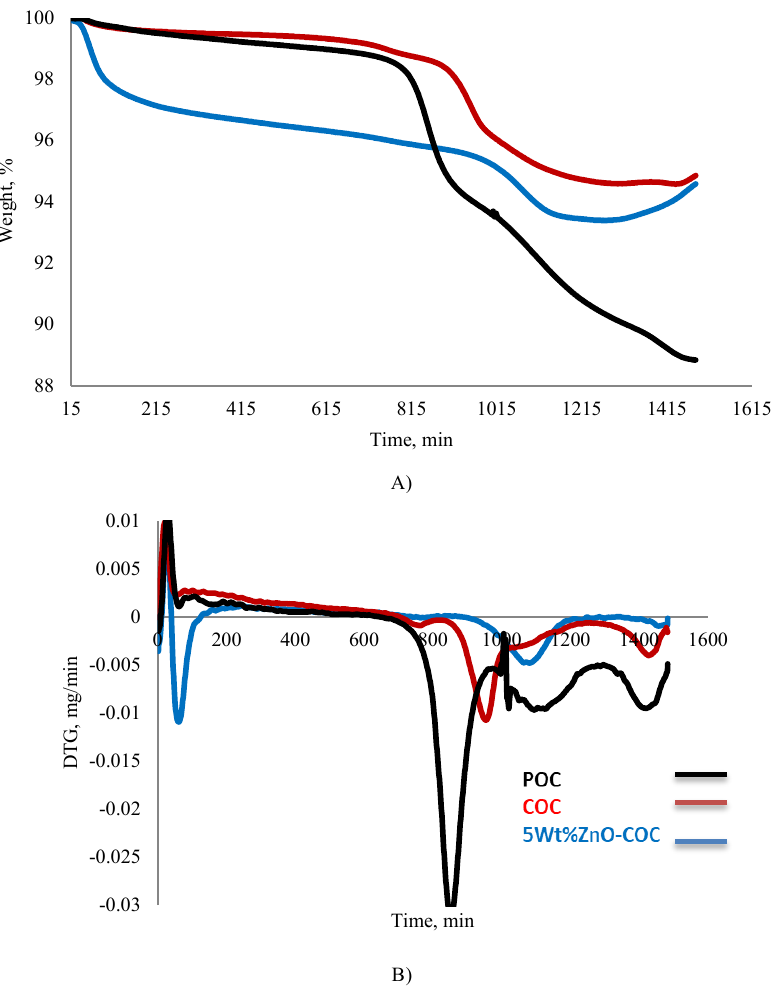
Fig. 2. ATG-ATD analysis of the samples under static airflow (A): ATG, (B): ATD. Fig. 2(A), as well as Fig. 2(B) curves show the TGA (thermogravimetric analysis) and TDA (differential thermal analysis) for the three samples (POC, COC and 05wt%ZnO-COC).